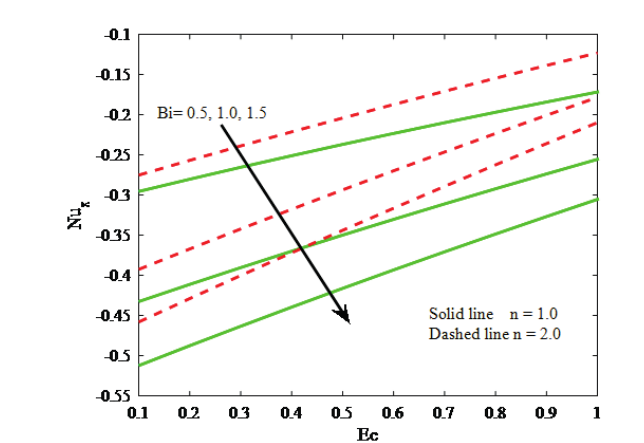
Fig. 14: Impact of Pr on temperature.